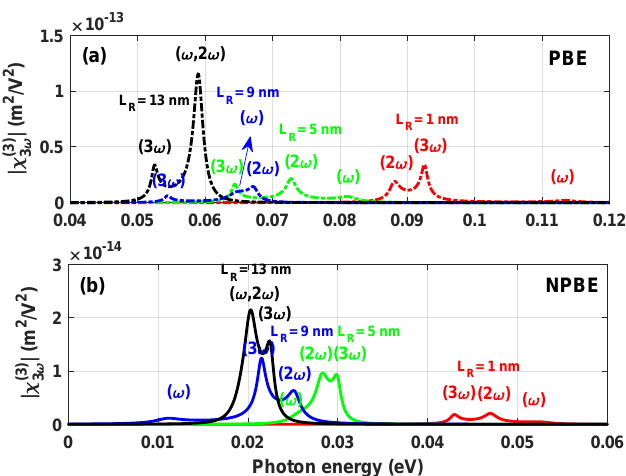
( 3 ) | as a function of the incident photon frequency ¯ h ω with L 3 ω